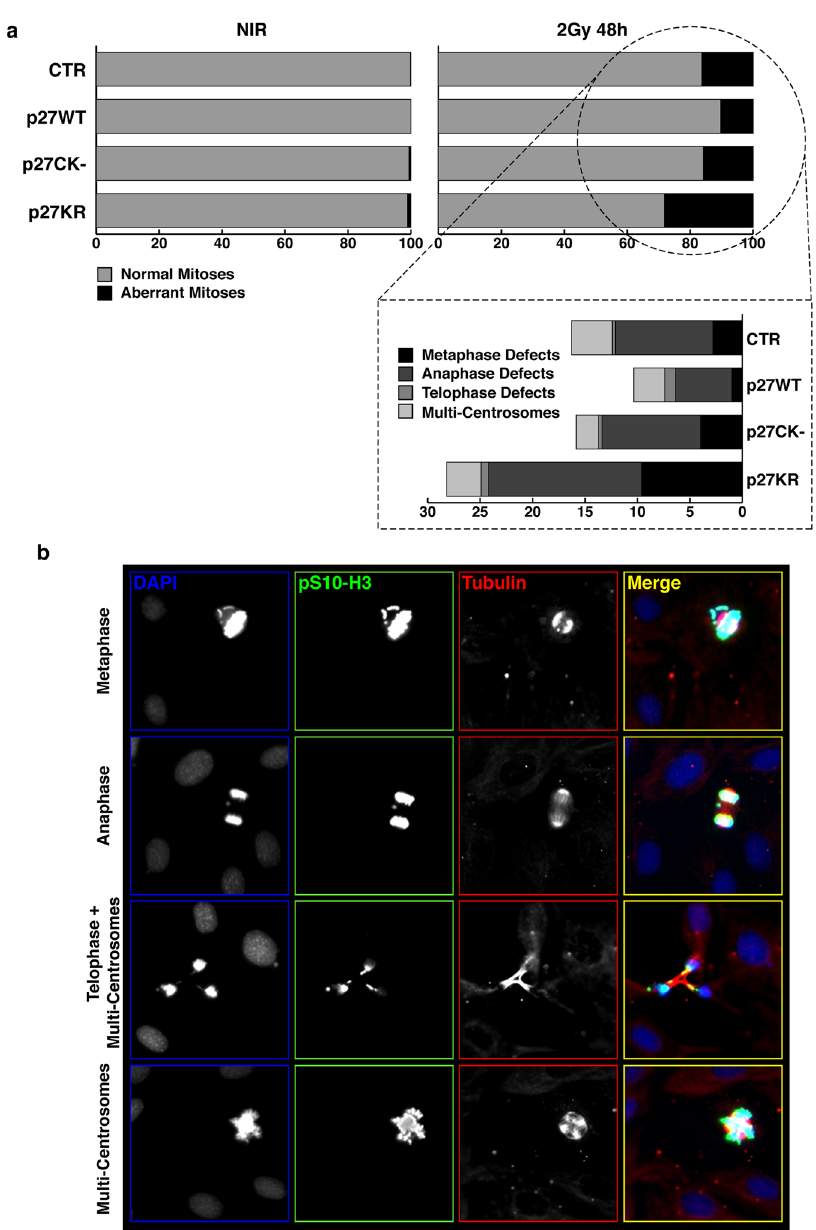
Figure 3. IR of p27KO cells is associated to mitotic aberrations. ( a ) Graph reports the quantification of aberrant mitoses encountered in the different cell clones when non-irradiated (NIR, left panels) or irradiated with 2 Gy (right panels) at 48 hours after radiation. Data are expressed as % of total cells. At the bottom, the aberrations were sub-classified respect to mitotic phases. ( b ) Representative pictures of cells reporting the above mentioned mitotic aberrations. Cells were stained for phospho-Ser10 Histon-H3 (pS10-H3) to identify mitotic cells (pseudocolored in green, shown in white), α Tubulin to highlight the mitotic spindle (pseudocolored in red, shown in white) and DAPI to identify the cell nuclei (pseudocolored in blue, shown in white). Only the merged picture is shown with